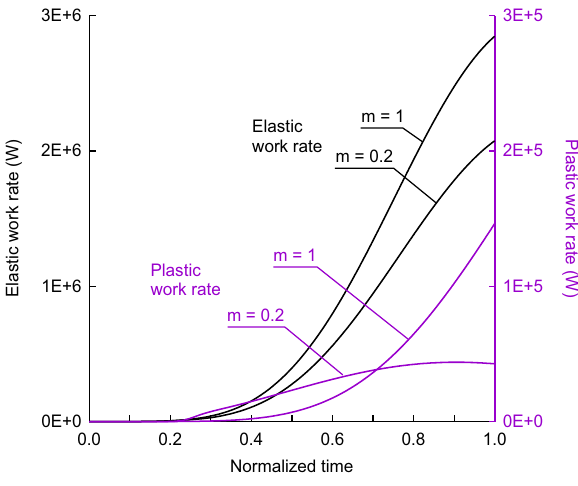
Fig. 6. Time dependence of the axial strain ratio for three elastic- viscoplastic materials with m = 0 . 2, 0 . 5, and 1.